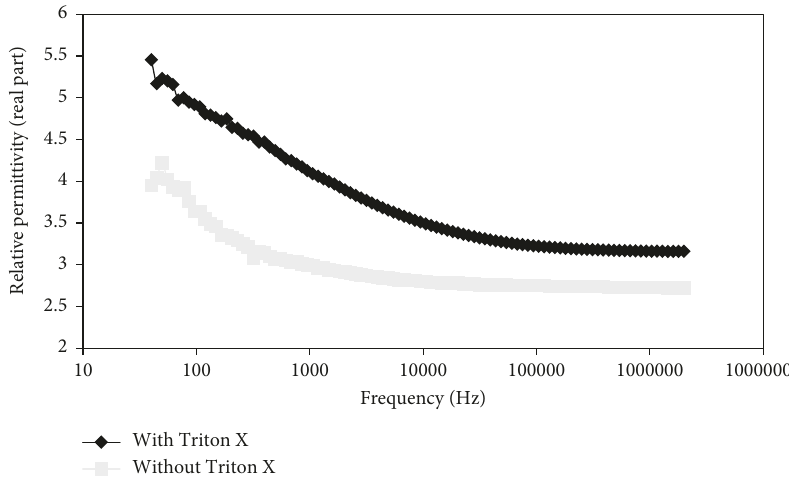
Figure 3: Variation of the permittivity as a function of frequency for silicone rubber/TiO